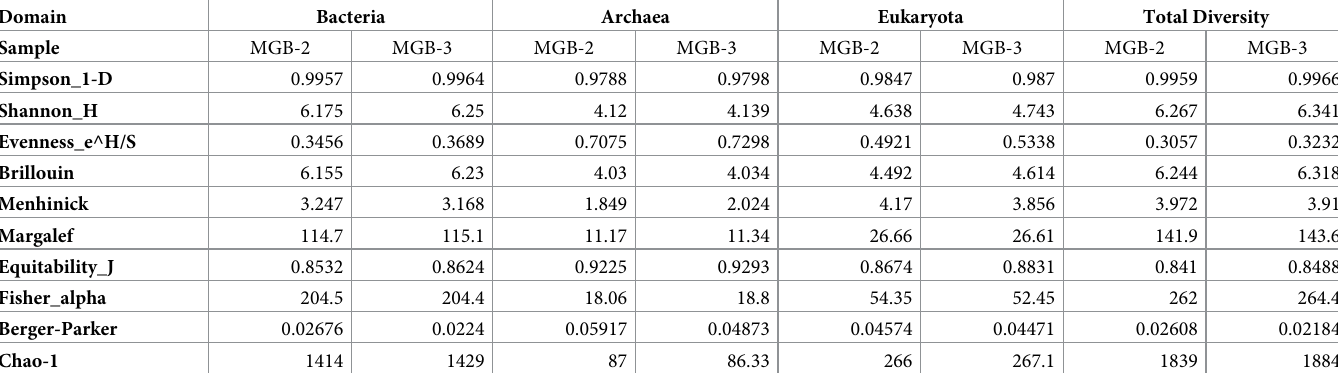
Table 2. Alpha diversity for bacterial, archaea and eukaryota communities of collected soil from polluted site near Bhilai steel plant.